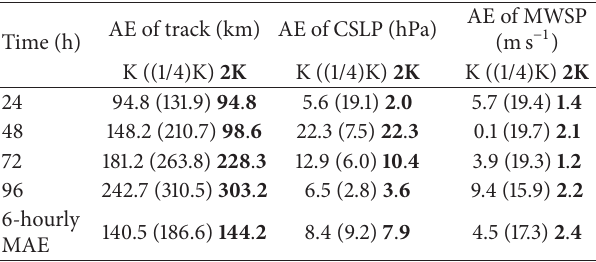
Table 2: Case 1-Neoguri: AE and MAE of track, CSLP, and